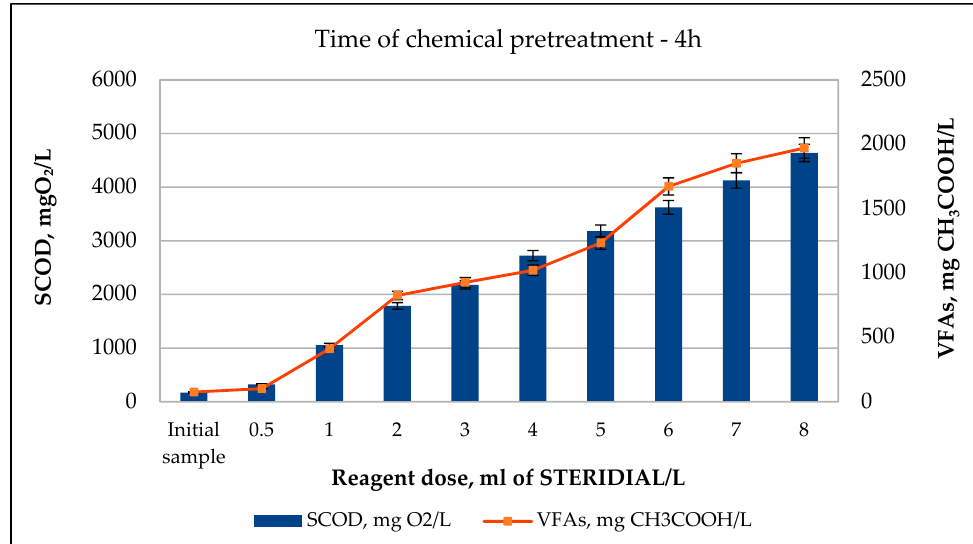
Figure 6. Changes in soluble chemical oxygen demand (SCOD) and concentration of volatile fatty acids (VFAs) determined in the supernatant liquor of chemically disintegrated excess sludge (pre- treatment time: 4 h) recorded in relation to the reagent doses used.